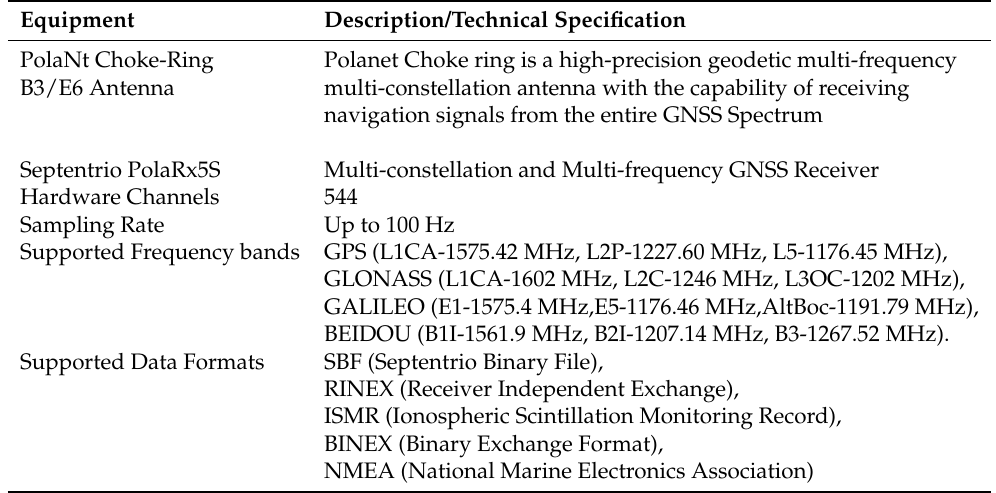
Table 3. Technical specifications of the equipment